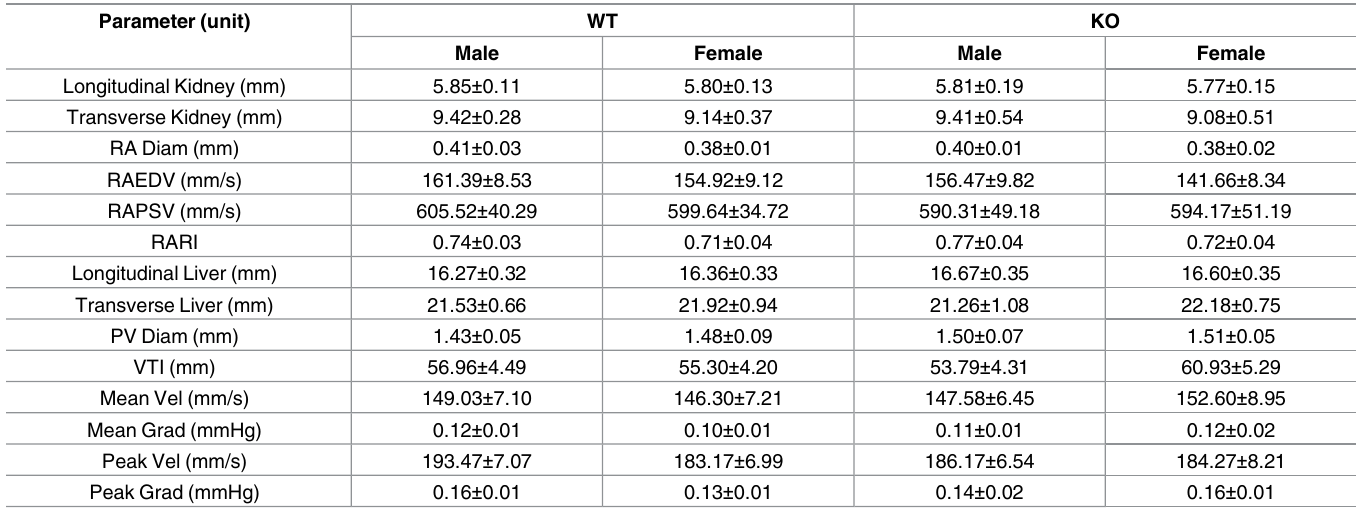
Table 3. Abdominal ultrasound parameter